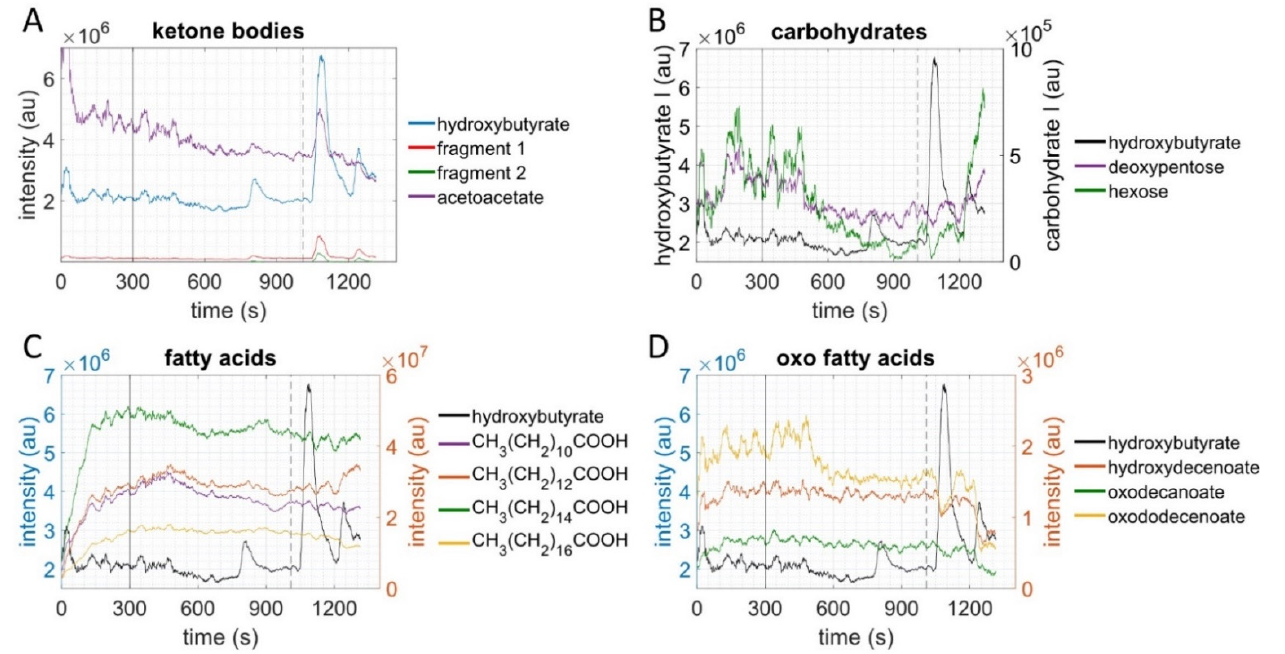
Figure 2. Intensity data over time from one sample subject (subject 6). Solid vertical lines represent the start on the ramp, dashed vertical lines represent VO2max. The left y-axis represents the ketone bodies in ( A ) and hydroxybutyrate in ( B , C ), respectively. The right y-axis represents the other metabolites. ( A ): Hydroxybutyrate (OHB), acetoacetate, and fragments; ( B ): OHB, hexose and deoxypentose; ( C ): OHB, stearate, palmitate, myristate and laurate; ( D ): OHB, hydroxydecenoate, oxodecanoate and oxodecenoate.